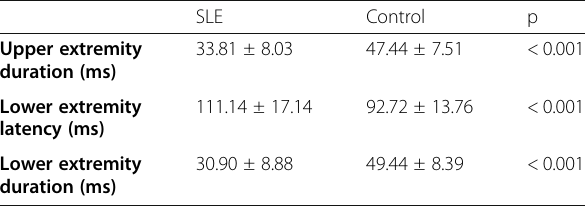
Table 2 Cutaneous silent period values of SLE patients and control group SLE Control